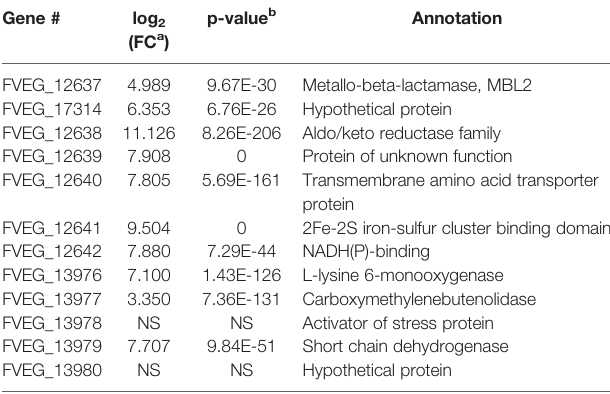
TABLE 1 | Gene clusters with differential expression upon exposure to 2- benzoxazolinone (BOA).